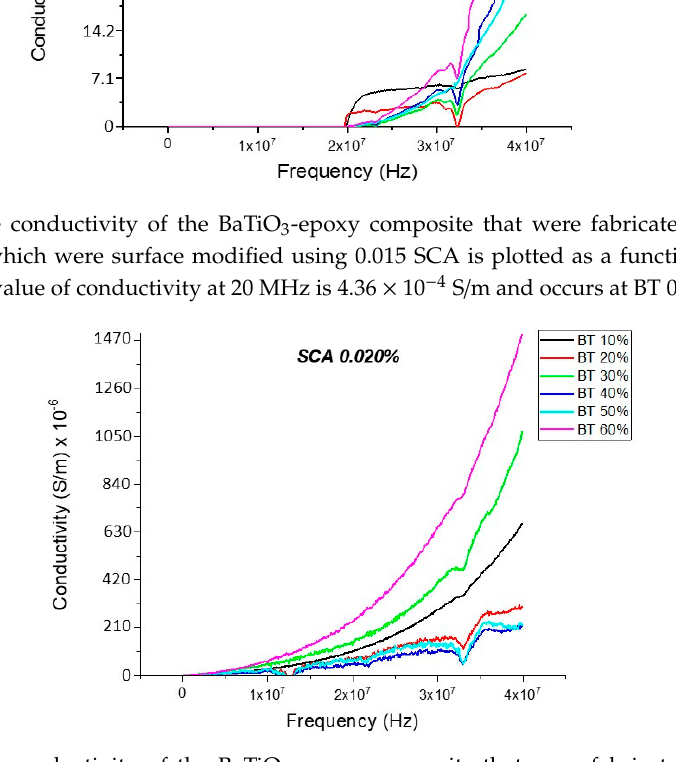
Figure 22. The conductivity of the BaTiO 3 -epoxy composite that were fabricated using BaTiO 3 nanoparticles which were surface modified using 0.020 SCA is plotted as a function of frequency. The maximum value of conductivity at 20 MHz is 2.38 × 10 − 4 S / m and occurs at BT 0.6.